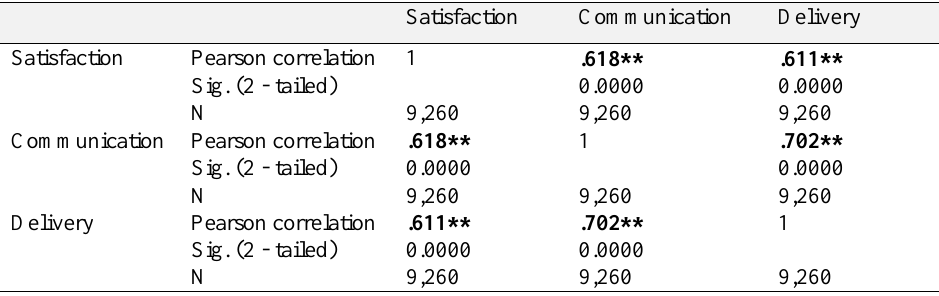
Table 6 – Pearson’s correlation Satisfaction Communication